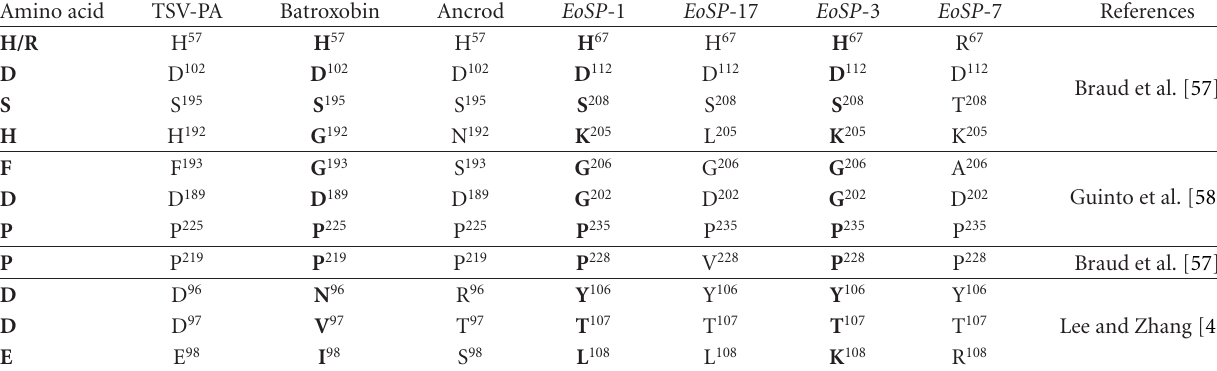
Table 2: Comparison of amino acid motifs which are responsible for the potent e ff ects and characterisation of some published venom serine proteases with the four EoSP